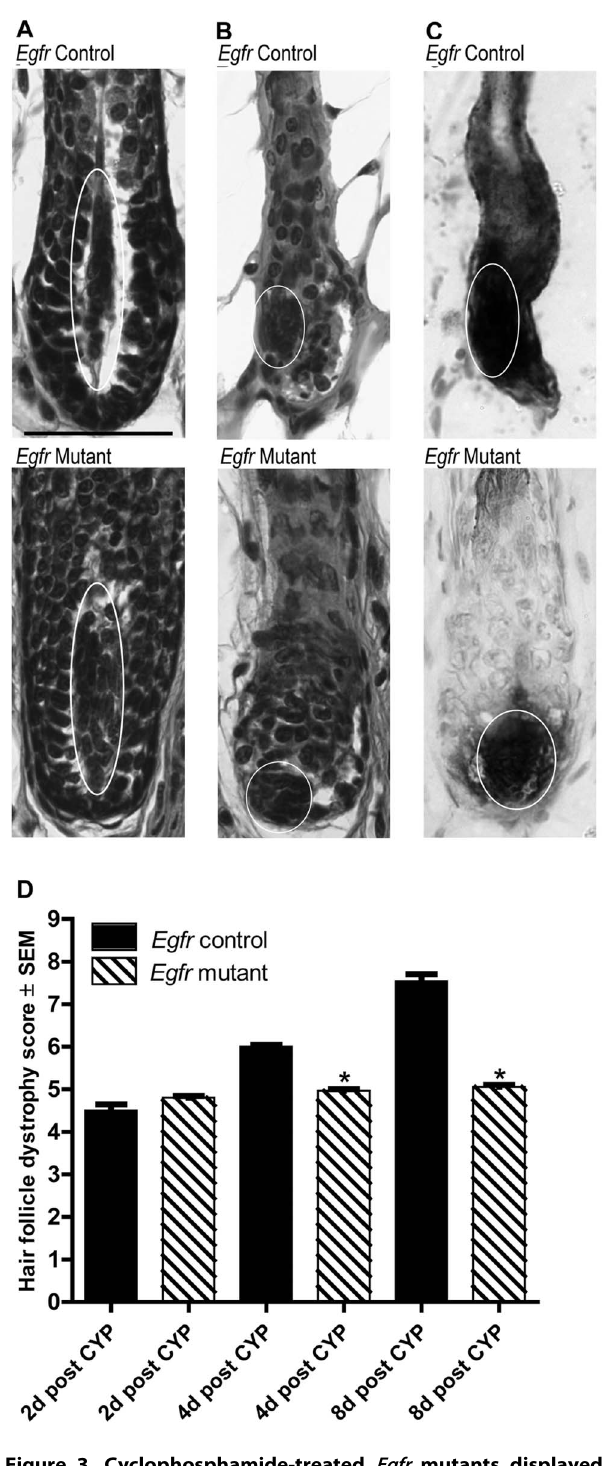
Figure 3. Cyclophosphamide-treated Egfr mutants displayed characteristics of early catagen with dermal papilla condensa- tion 2d post administration. A–B) Hematoxylin and eosin stained sections of vehicle treated controls (A top) and mutants (A bottom) displayed anagen dermal papilla with spindle shapes (ovals) surrounded by matrix keratinocytes. Control (B top) and mutant (B bottom) dermal papilla condensed to the proximal hair follicle by 2d following cyclophosphamide (ovals). Endogenous alkaline phosphatase con- firmed dermal papilla position in controls (C top, oval) and mutants (C bottom, oval) at 2d. Scale bar indicates 50 m m. D) Hair